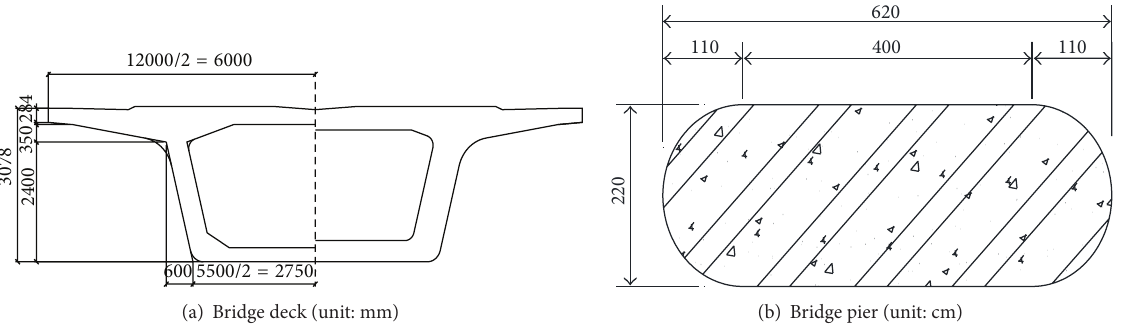
Figure 8: Cross-section of bridge deck and pier.